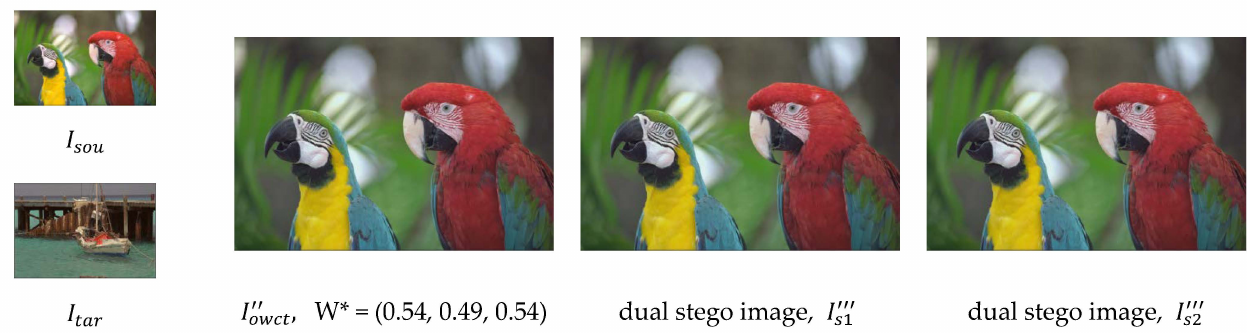
Figure 10. The visual inspection of the test image